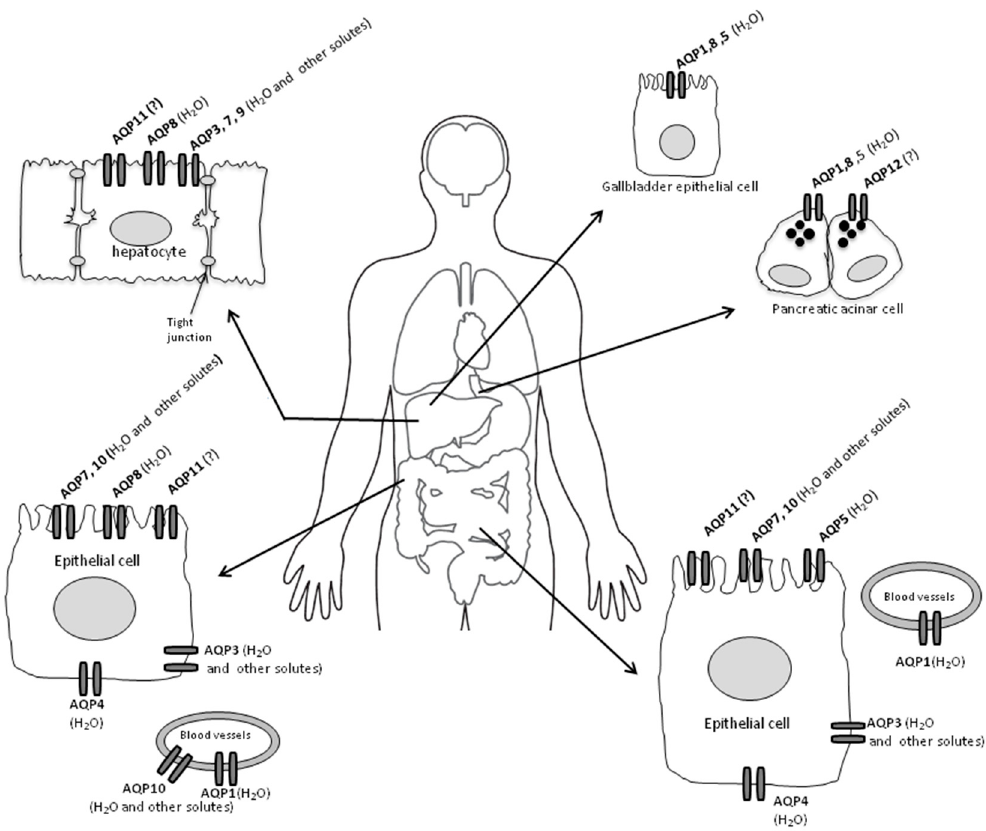
Figure 1. Main AQPs’ cell polarity and channel protein distribution in the gastrointestinal tract and associated organs. (?) = unknown role or function. For the specific intracellular localization of different AQPs see text.